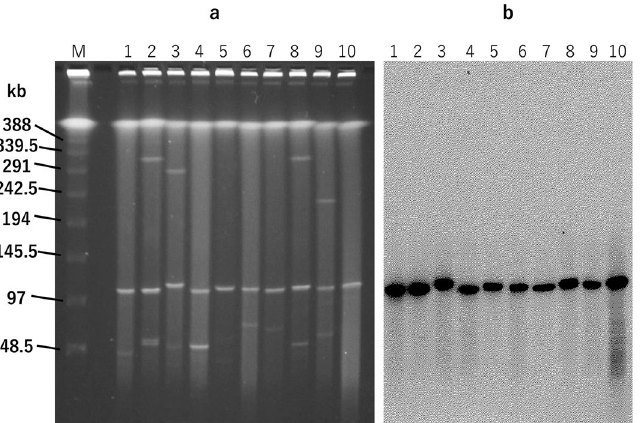
Figure 4. Pulsed-field gel electrophoresis of S1-digested plasmid DNAs from VanA-type vancomycin-resistant E. faecium isolates ( a ) and Southern hybridization with the vanA probe ( b ). ( a ) Lanes (left to right): M, molecular marker; 1, S209 (isolate), Er (strain), 10/2017 (date of sample collection), NA (pulsotype of Efm); 2, S398, Efm, 11/2017, A; 3, S477, Efm, 11/2017, G; 4, S844, Efm, 12/2017, B; 5, S1391, Efm, singleton; 6, S1693, Ea, 5/2018, NA; 7, S3088, Ea, 9/2018, NA; 8, S4573, Efm, 3/2018, L; 9, S4694Efm, Efm, 3/2018, singleton; 10, S4694Eg, Eg, 3/2018, NA. Er, E. raffinosus ; Efm, E. faecium ; Ea, E. avium ; Eg, E. gallinarum ; NA, not applicable. ( b ) Lanes (left to right): same as ( a ).